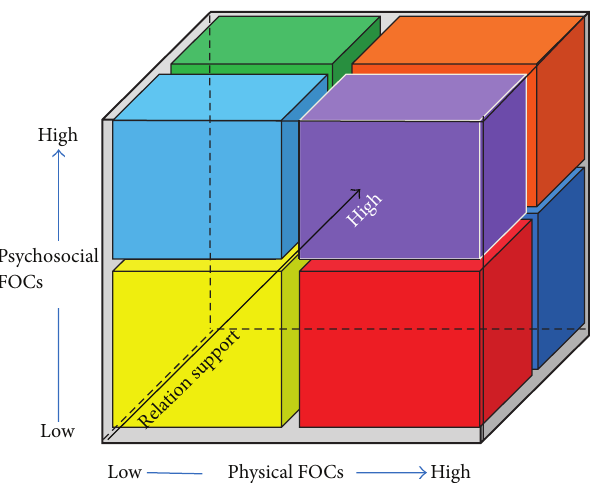
Figure 3: Fundamentals of Care: physical, psychosocial, and rela- tional